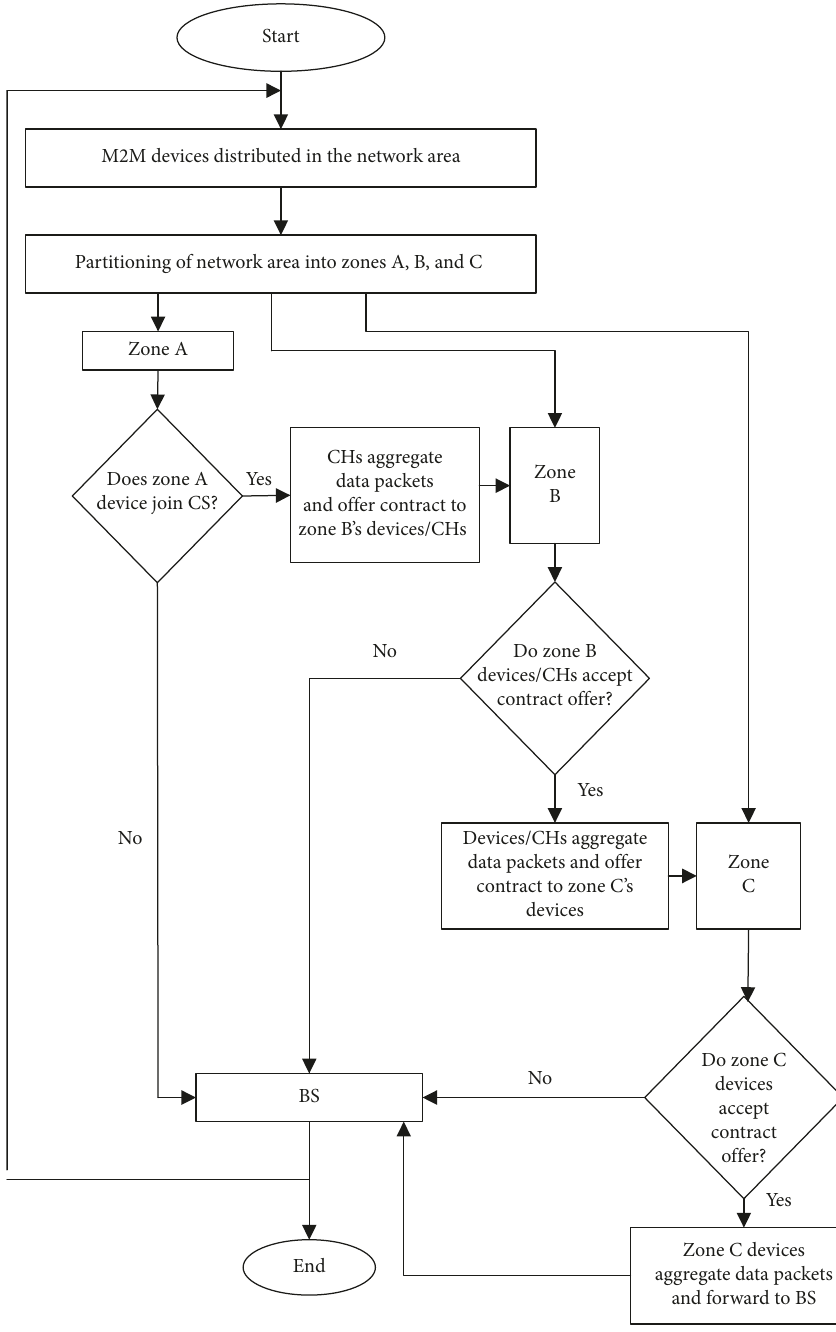
Figure 4: Flow chart of the CGTCI